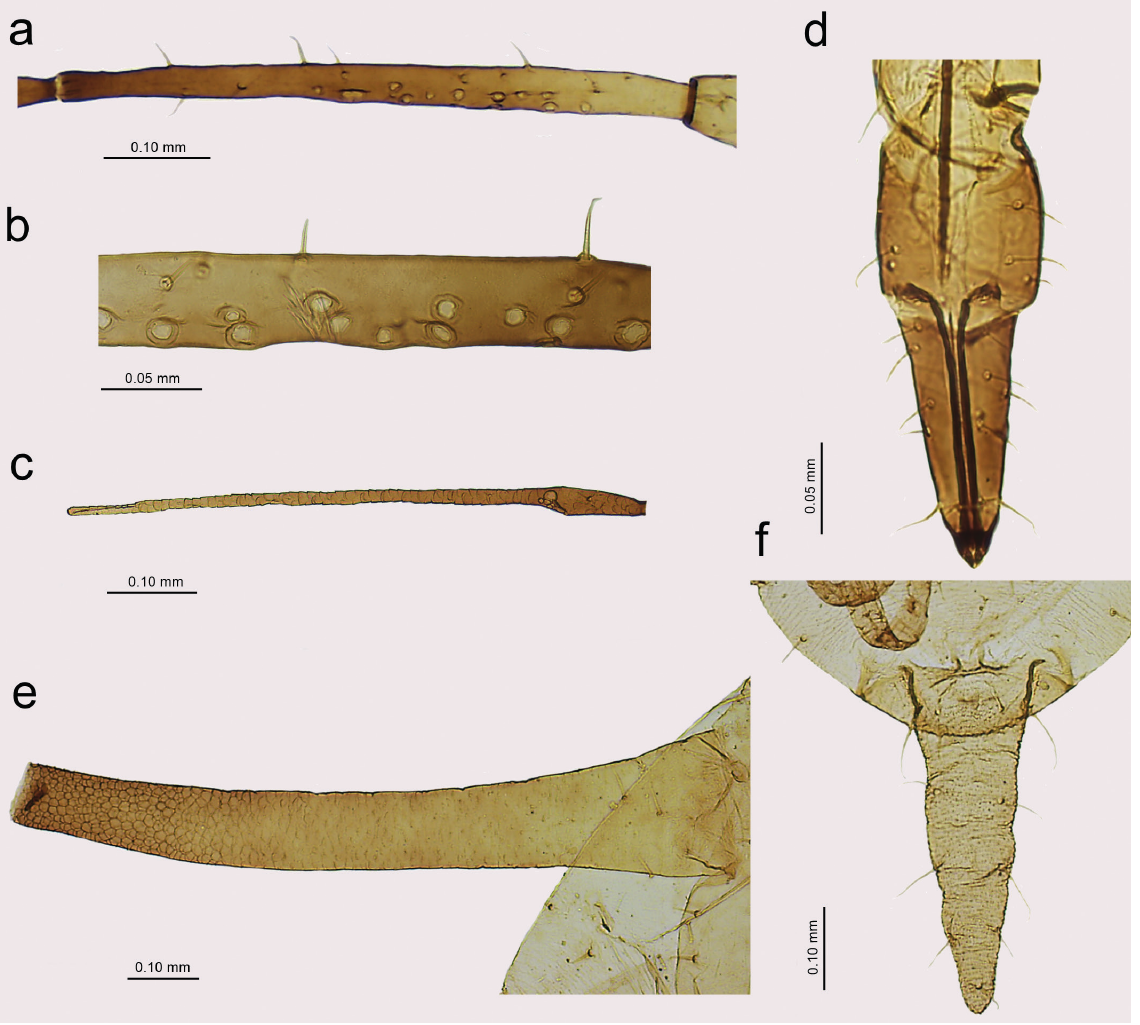
Fig. 2. Uroleucon ( Lambersius ) robinsoni sp. nov., holotype, apterous viviparous female (NHMUK 010121495). a . ANT III. b . Secondary rhinaria on ANT III. c . ANT VI. d . Ultimate rostral (III–V) segments. e . Siphunculus. f .